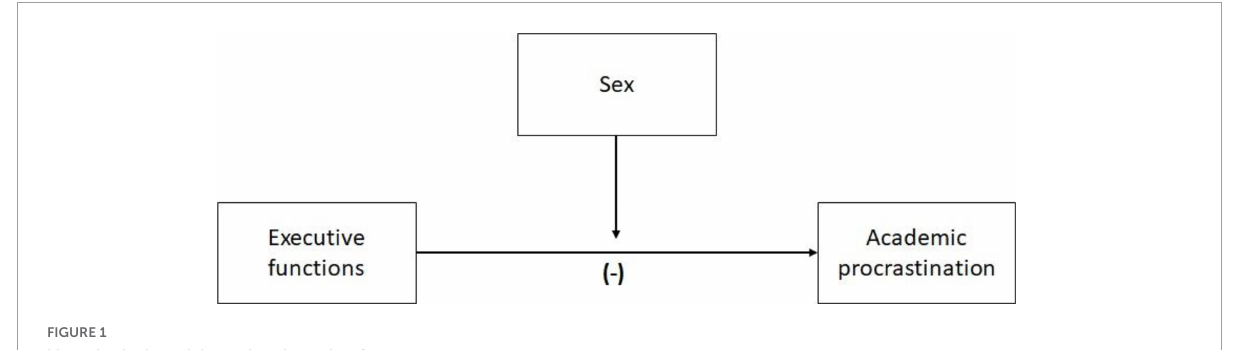
FIGURE1 Hypothetical model: moderating role of sex.